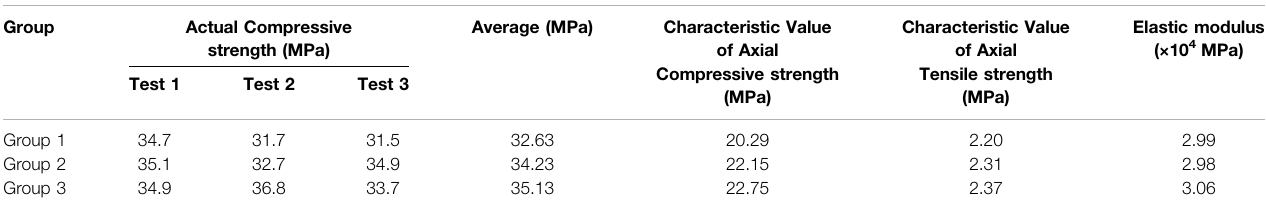
TABLE 2 | Concrete performance